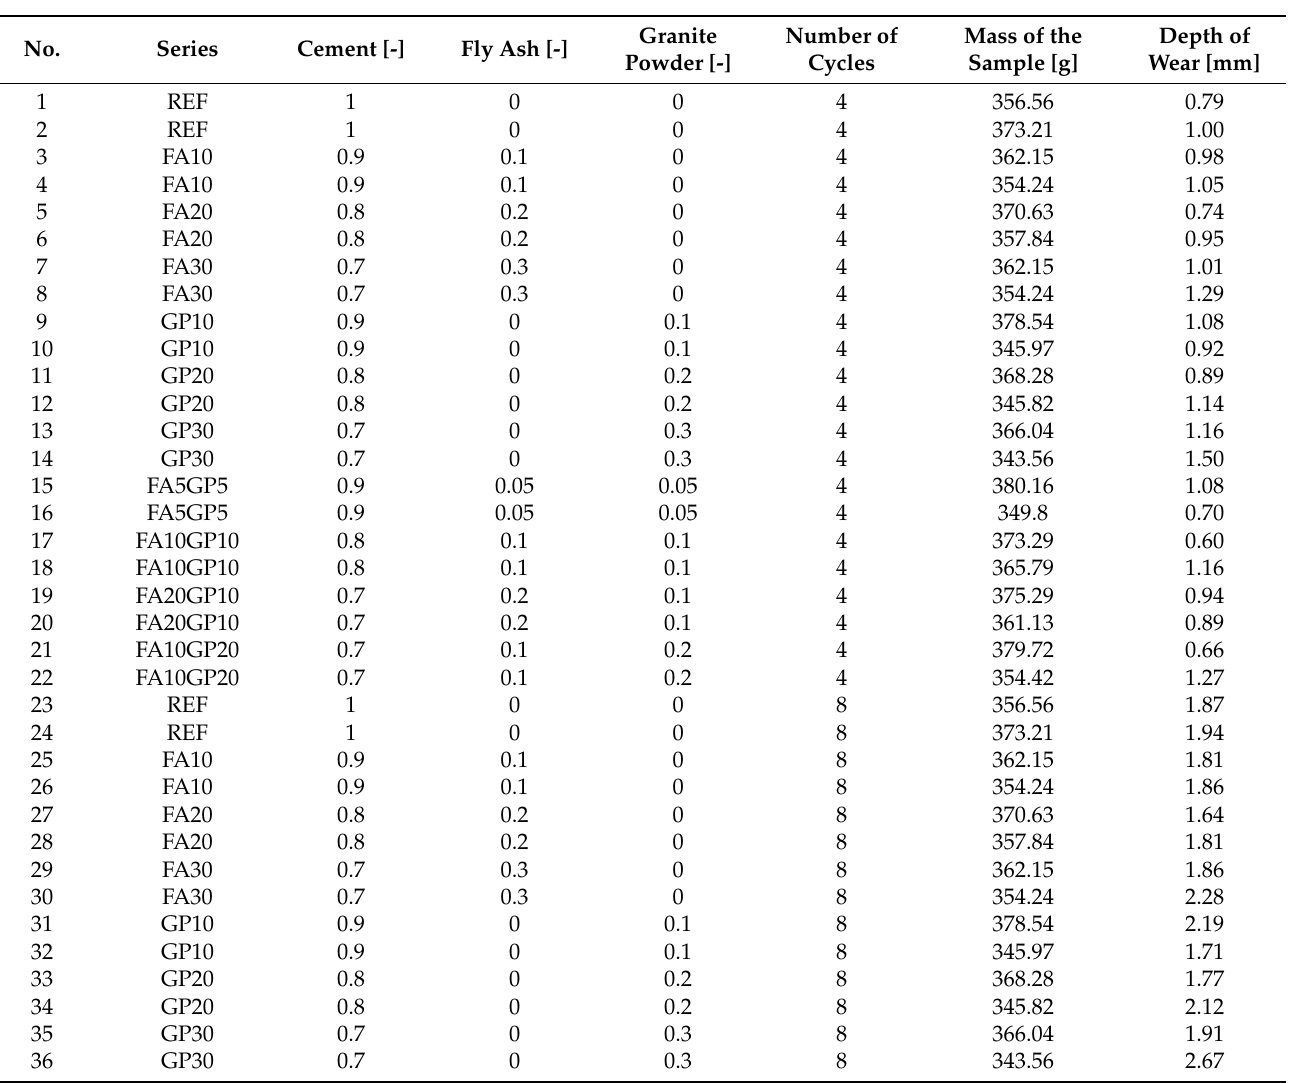
Table 4. Selected input and output